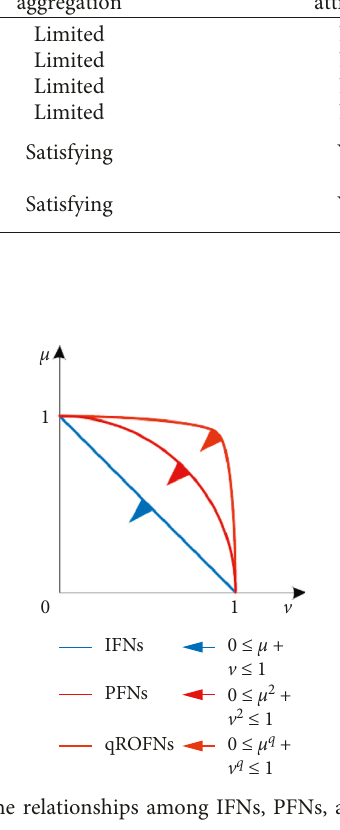
Table 3: The results of the qualitative comparison with the MCGDM methods based on Muirhead aggregation operators of IFNs and PFNs. MCGDM method